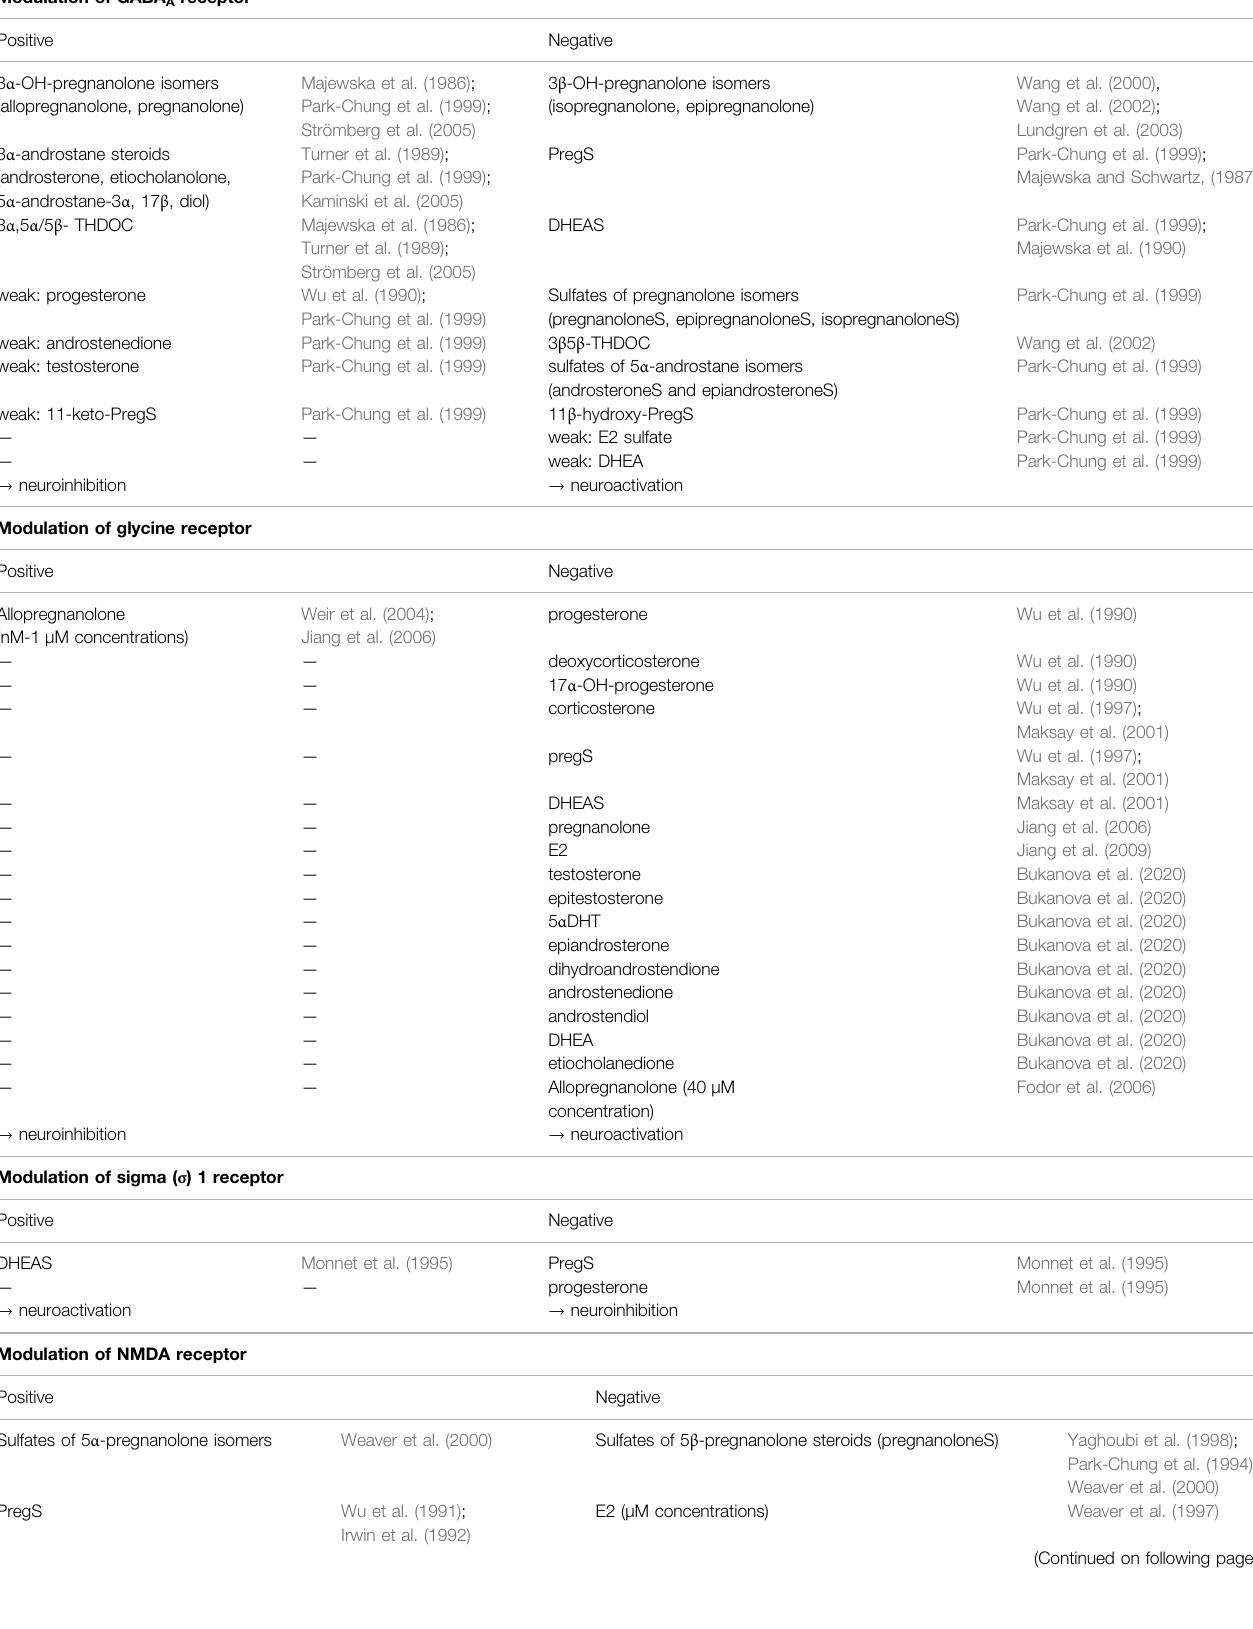
TABLE 1 | Positive and negative modulators of selected membrane